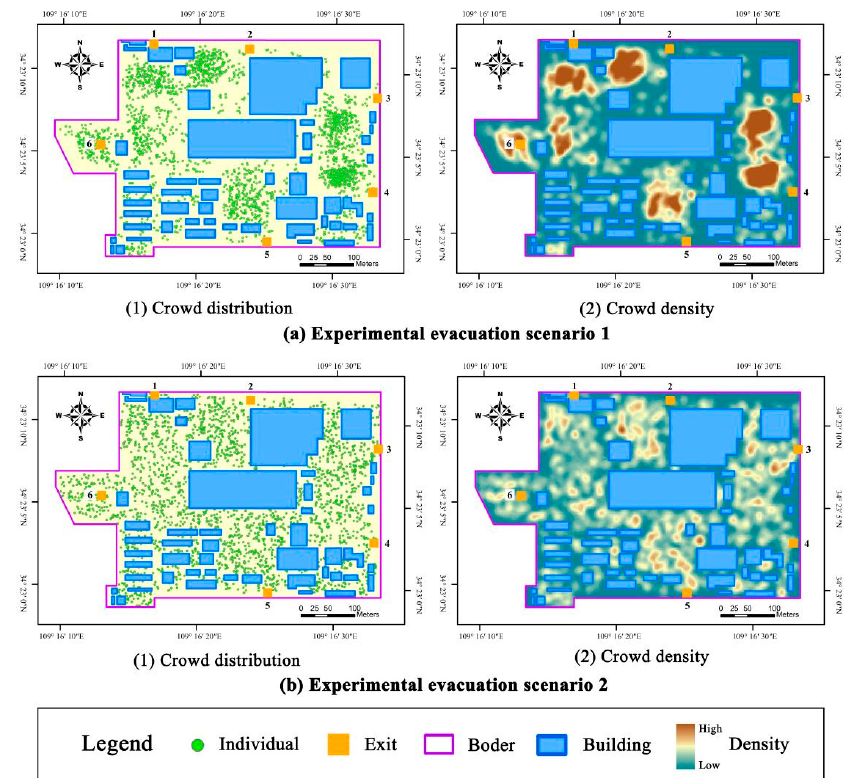
Figure 10. Experimental evacuation scenarios with different crowd distributions.